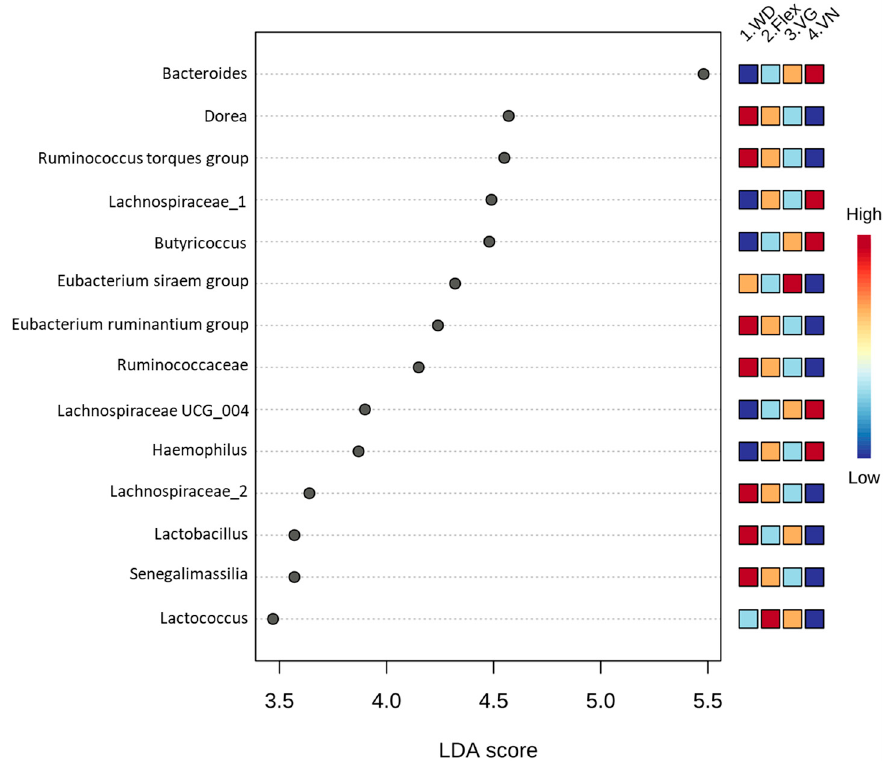
Figure 4. LefSe analysis was done in MicrobiomeAnalyst with the filtered data set. The four diets were set as color-coded abundancy classes (high = red to low = blue). Fourteen significant biomarkers ( p < 0.05) were identi fi ed. LDA score = linear discriminant analysis score.